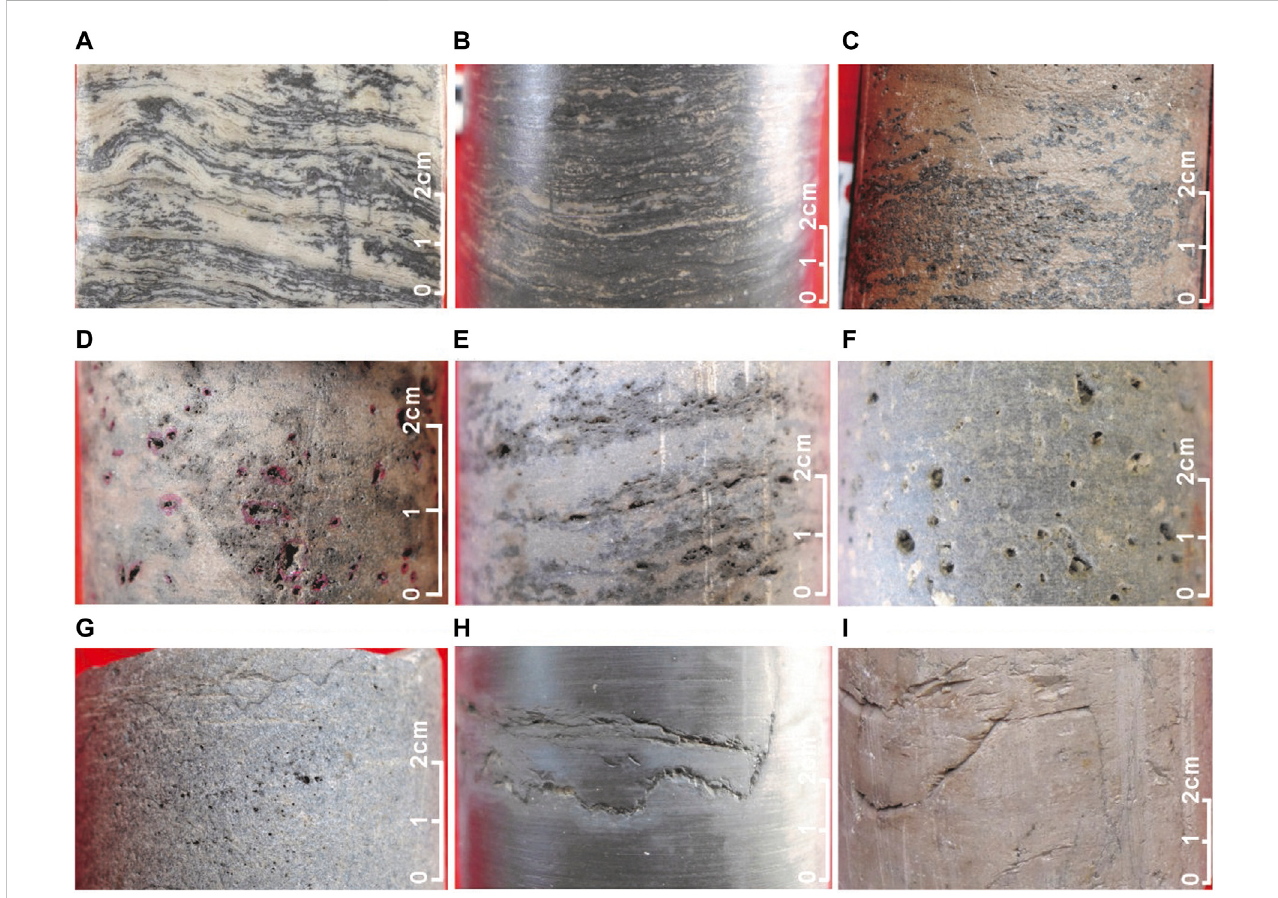
FIGURE 2 Cores of main microbialites and non-microbialites types. (A) MX105, 5335.14 m, light-grey wavy stromatolite. (B) MX105, 5356.27 m, dark-grey wavy stromatolite. (C) GS7, 5325.52 m, spotted thrombolite. (D) MX105, 5316.88 m, spotted thrombolite. (E) MX105, 5323.45 m, layered thrombolite. (F) MX105, 5303.14 m, dolograinstone. (G) GS16, 5452.86 m, dolopackstone. (H) MX105, 5362.15 m, dark-grey dolomudstone. (I) GS21, 5284 m, light-grey